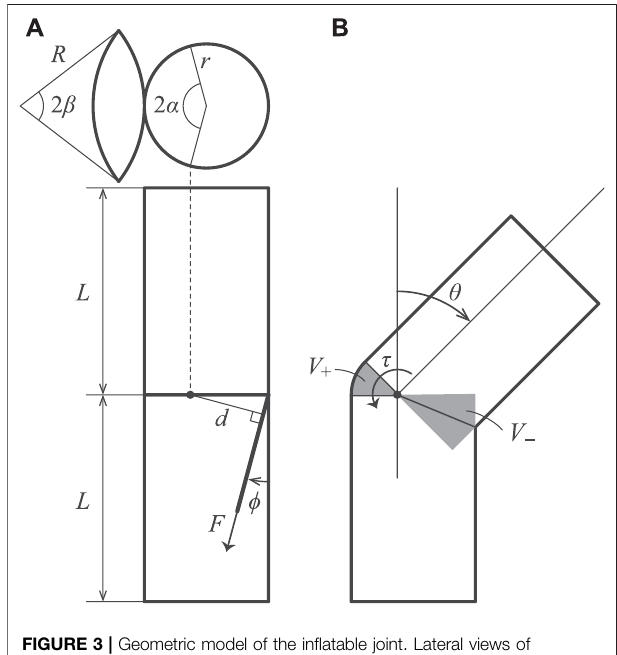
FIGURE 3 | Geometric model of the in fl atable joint. Lateral views of neutral and bending states, and a leaf-shaped patch are shown.